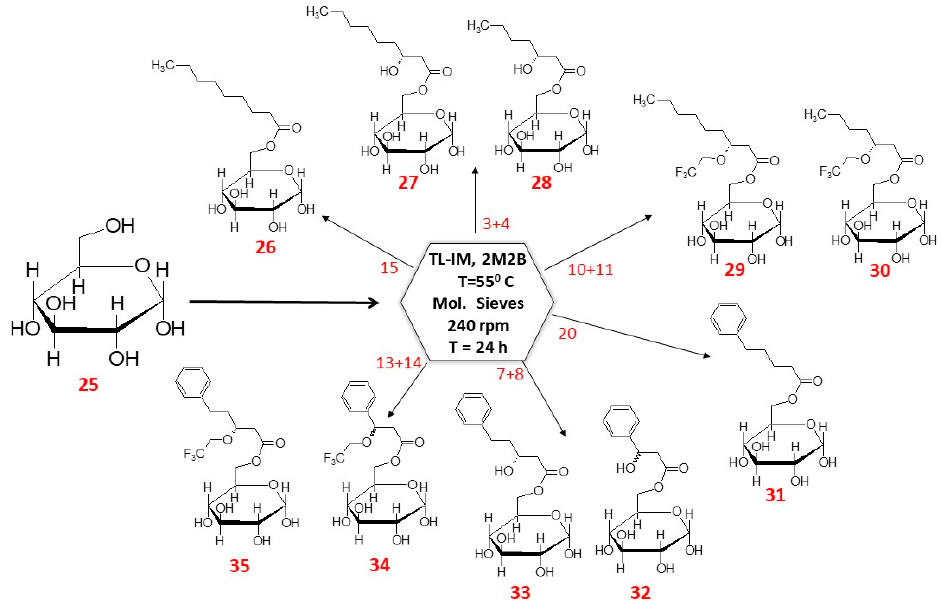
Figure 2. Scheme of synthesis SFAE. 25. Glucose [(2 S ,5 S )-6-(hydroxymethyl)oxane-2,3,4,5-tetrol];